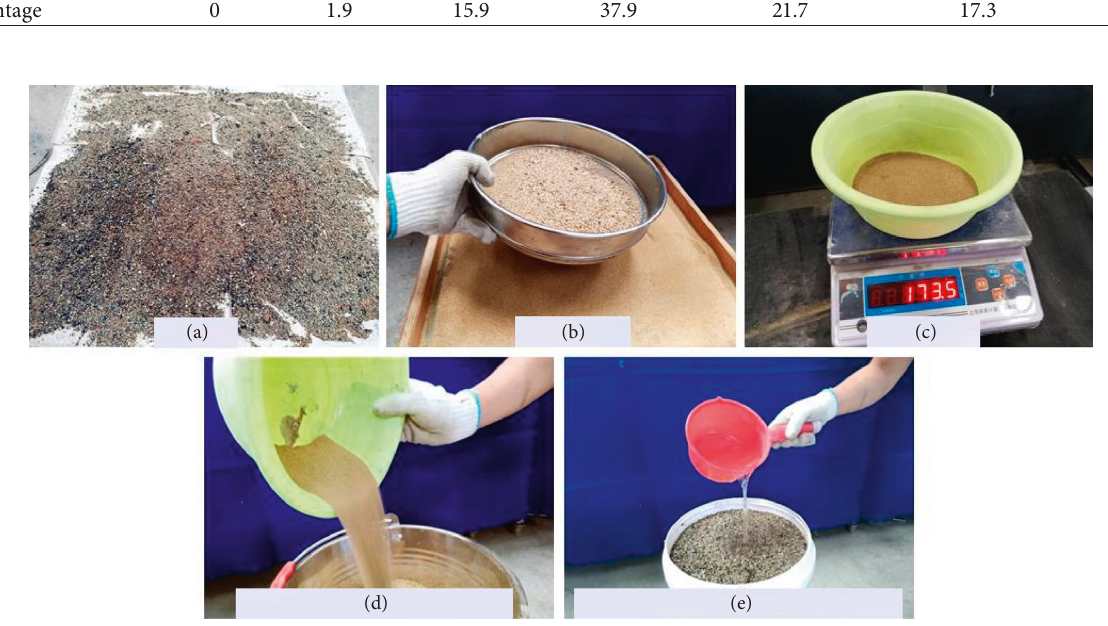
Figure 3: Remolding the sand configuration process.